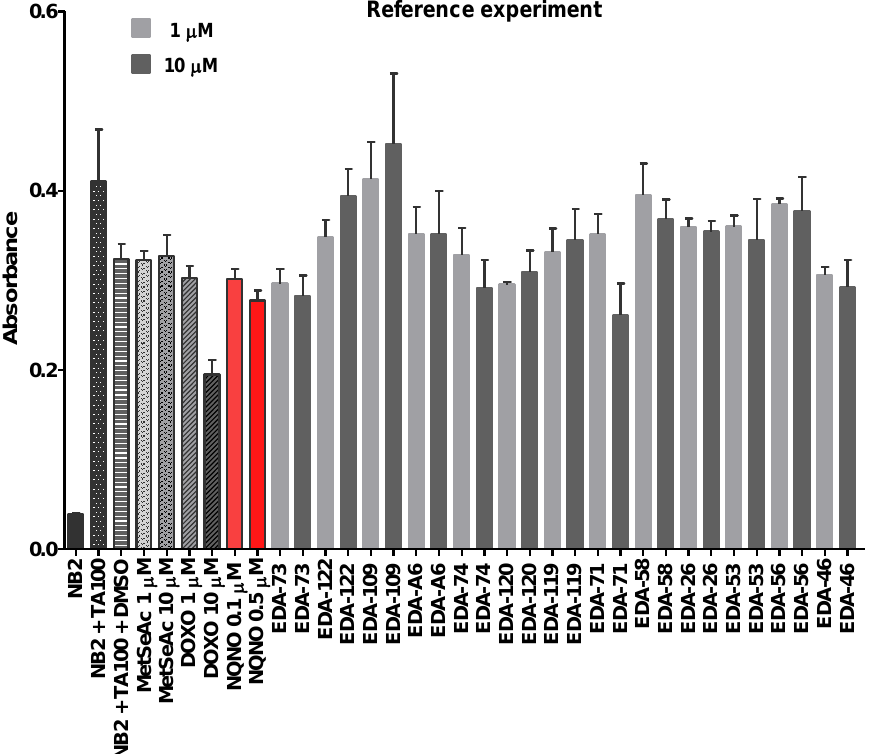
Figure 10. Reference experiment results for organic selenocompounds in two concentrations: 1 µM (marked with light grey) and 10 µM (marked with dark grey); NB2 — nutrient broth no. 2 without bacteria (background control). NB2 + TA100 — control with Salmonella Typhimurium TA100 strain alone; NB2 + TA100 + DMSO — solvent control; MetSeAc — methylseleninic acid (anticancer selenocompound); DOXO — doxorubicin (standard cytostatic compound).